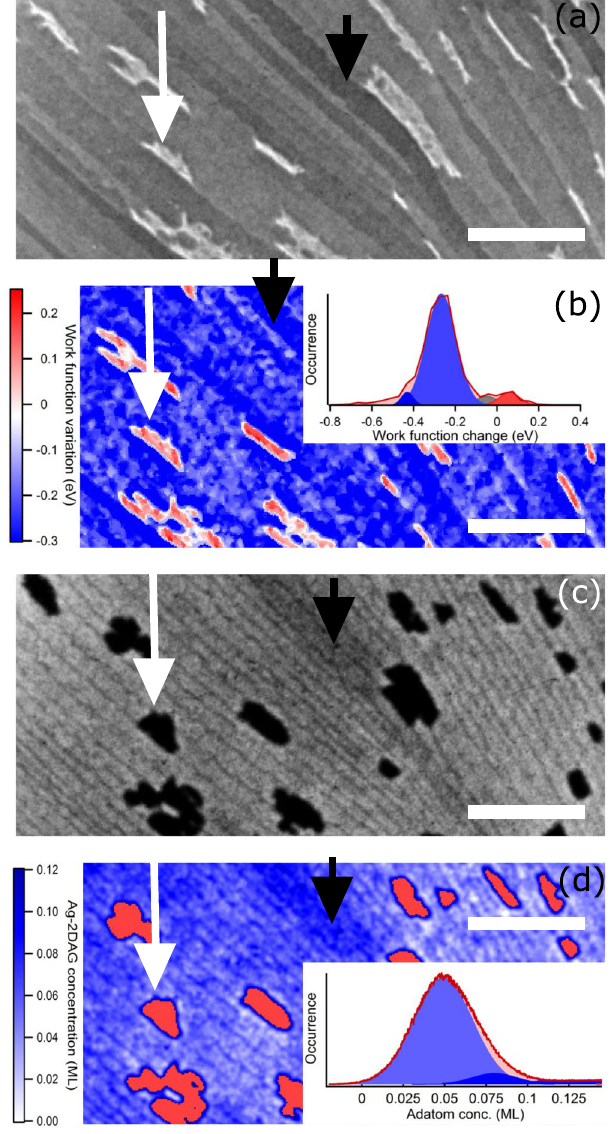
Figure 3. ( a ) Mirror Electron Microscopy image of a 3 -Ag surface during a 2DAG-Ag deposition at 220 K after the nucleation of 3D island (white intensity) showing intensity inhomogeneities ( ε = 0 eV). ( b ) 2D map of the surface work function change with respect to the 3 -Ag surface obtained by reflectivity measurements (see Methods). The inset shows the histogram of the work function map. ( c ) LEEM image ( ε = 24 eV) acquired 8 min before Fig. 3(a,b). ( d ) The 2D map of the Ag-2DAG concentration derived from image ( c ) (see Methods). The 3D Ag islands have been coloured in red in Fig. 3(d). The inset shows the histogram of the Ag adatom gas concentration. See the text for the arrow meaning. For all images, the scale bar is 2 μ